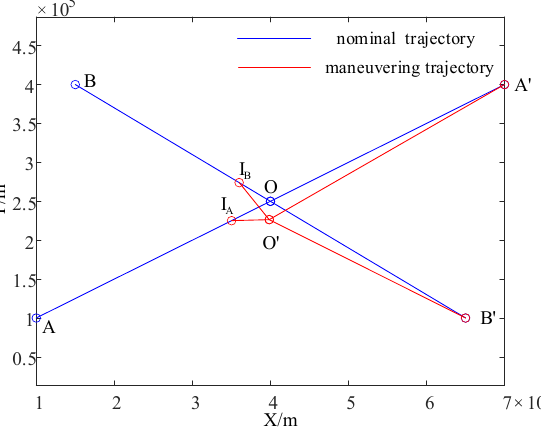
Figure 8. Trajectory diagram of integrated optimal separation assurance strategy. Table 3. Results of three separation assurance strategies.